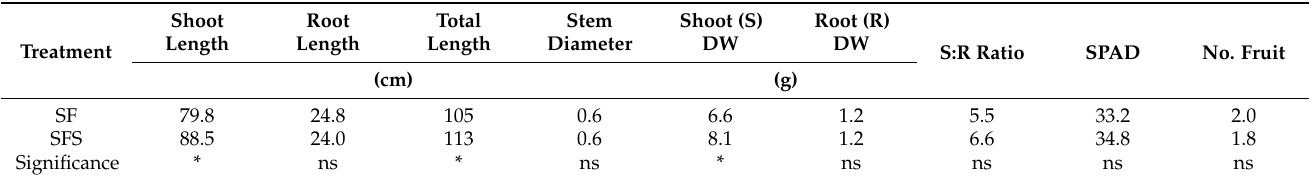
Table 2. Growth of red pepper seedlings as affected by starfish (SF)- and starfish + seaweed (SFS)-liquid fertilizers. Shoot Length Treatment